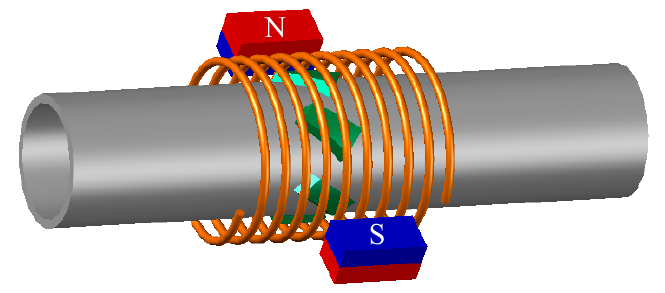
Figure 2. Design of the magnetostrictive transducer.